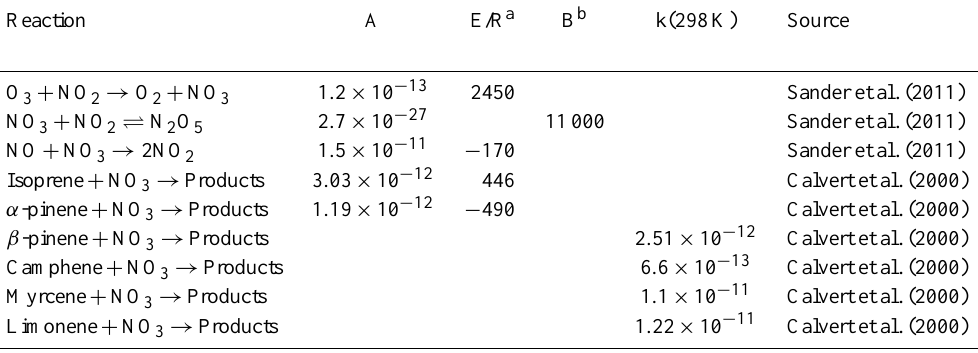
Table 1. NO 3 kinetic rate constants and equilibrium constants used to determine losses. Reaction A E/R a B b k(298K) Source O 3 + NO 2 → O 2 + NO 3 1 . 2 × 10 − 13 2450 Sander et al. (2011) NO 3 + NO 2 (cid:10) N 2 O 5 2 . 7 × 10 − 27 11000 Sander et al. (2011) NO + NO 3 → 2NO 2 1 . 5 × 10 − 11 − 170 Sander et al. (2011) Isoprene + NO 3 → Products 3 . 03 × 10 − 12 446 Calvert et al. (2000) α -pinene + NO 3 → Products 1 . 19 × 10 − 12 − 490 Calvert et al. (2000) β -pinene + NO 3 → Products 2 . 51 × 10 − 12 Calvert et al. (2000) Camphene + NO 3 → Products 6 . 6 × 10 − 13 Calvert et al. (2000) Myrcene + NO 3 → Products 1 . 1 × 10 − 11 Calvert et al. (2000) 1 . 22 × 10 −